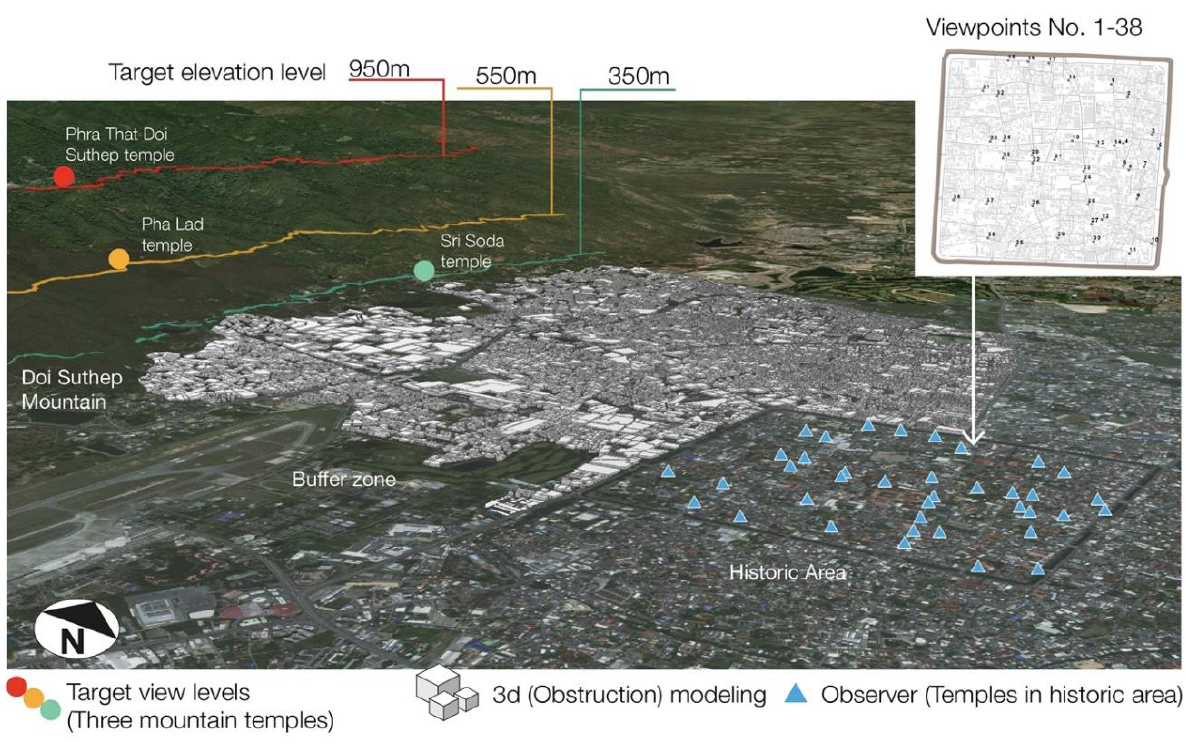
Figure 6. Determination of mountain skyline levels and viewpoint locations (Source: Authors).